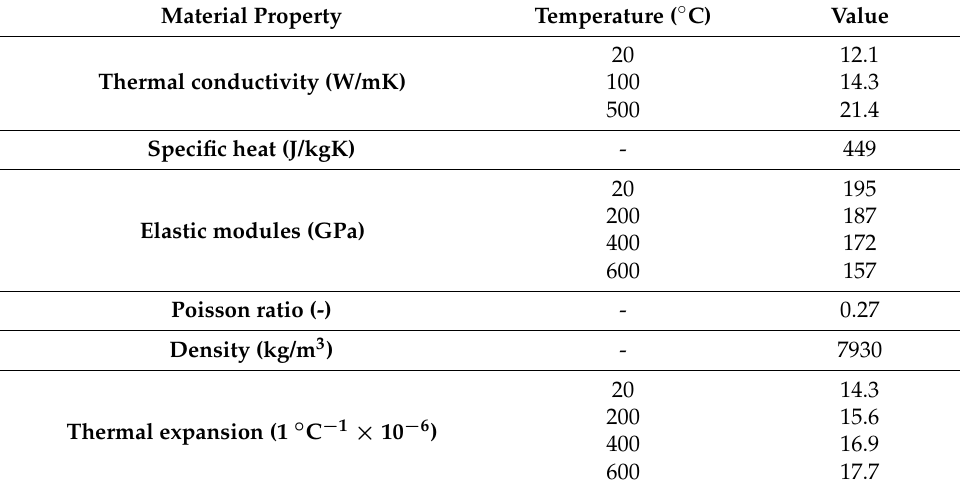
Figure 6. Sequence of simulation analysis steps, commencing at Start. Table 3. Material properties used in the simulation model.